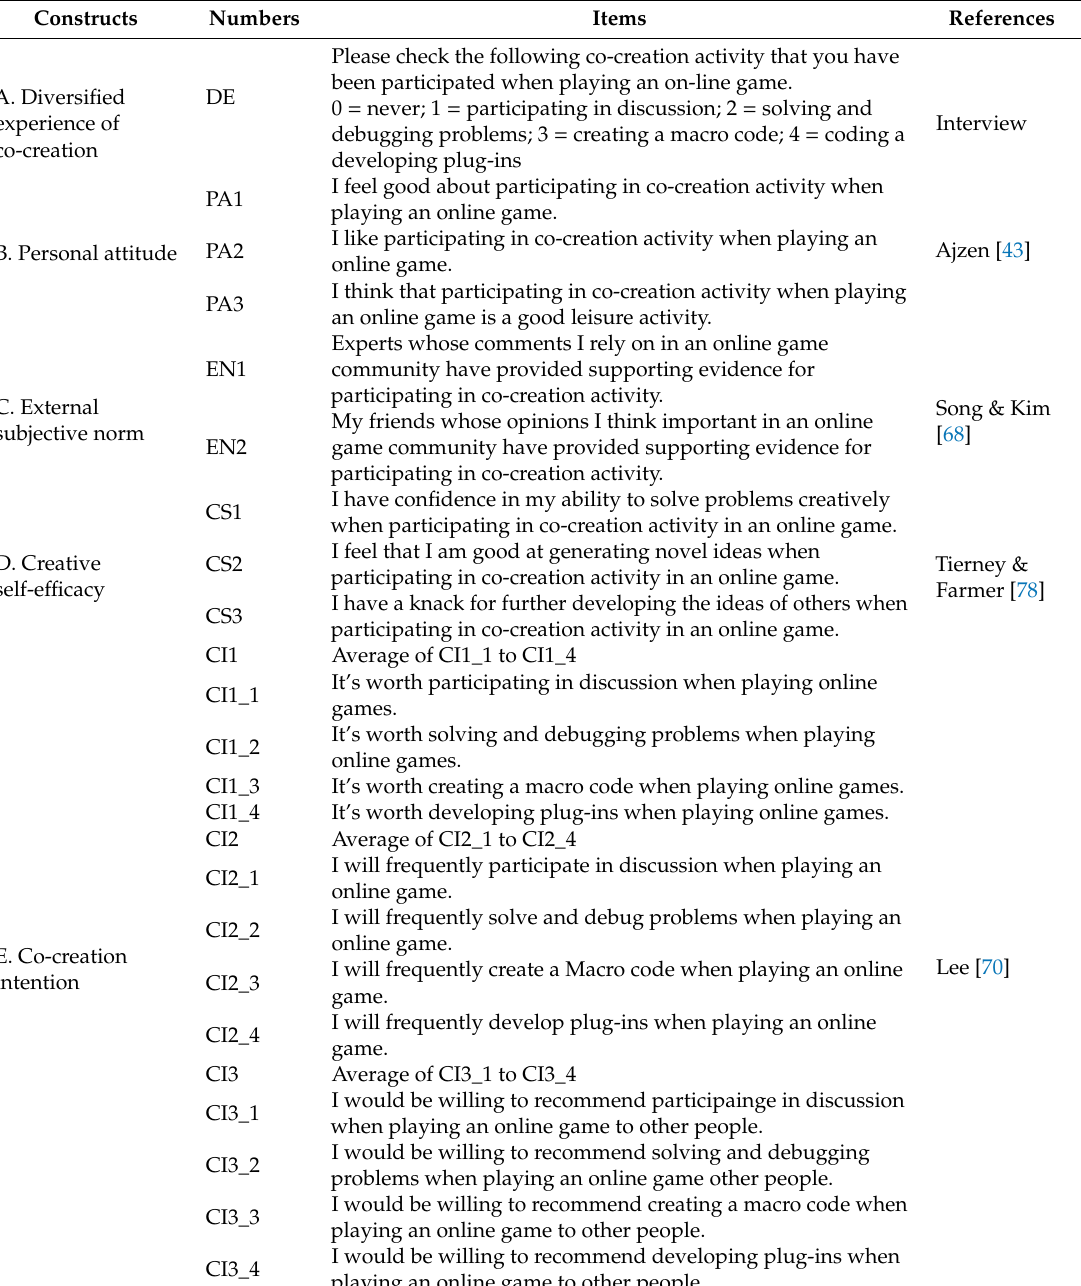
Table A1. Questionnaire